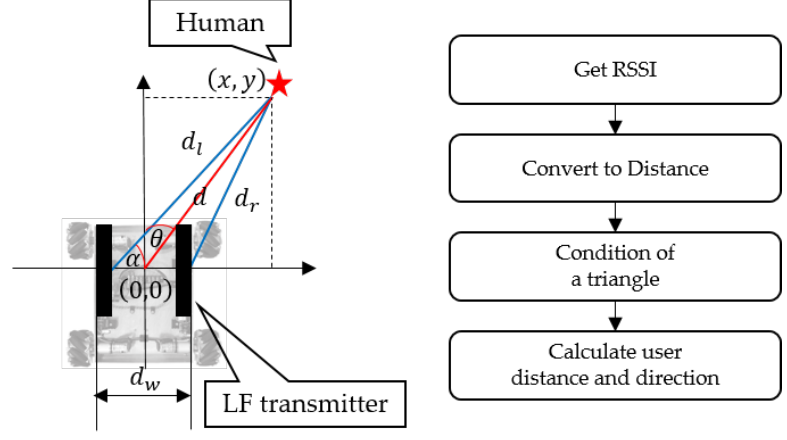
Figure 6. Method for obtaining a user’s location information.